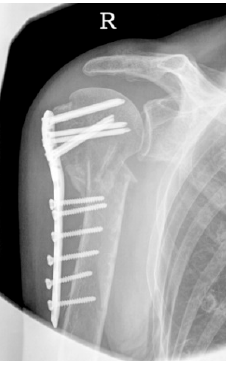
Figure 16. Complication Type 3. a.p. radiograph of the right shoulder after angular stable plate osteosynthesis shows a displacement of the humeral shaft area, so the fixation of the plate osteosynthesis is no longer guaranteed. In contrast, the humeral head position is regular.